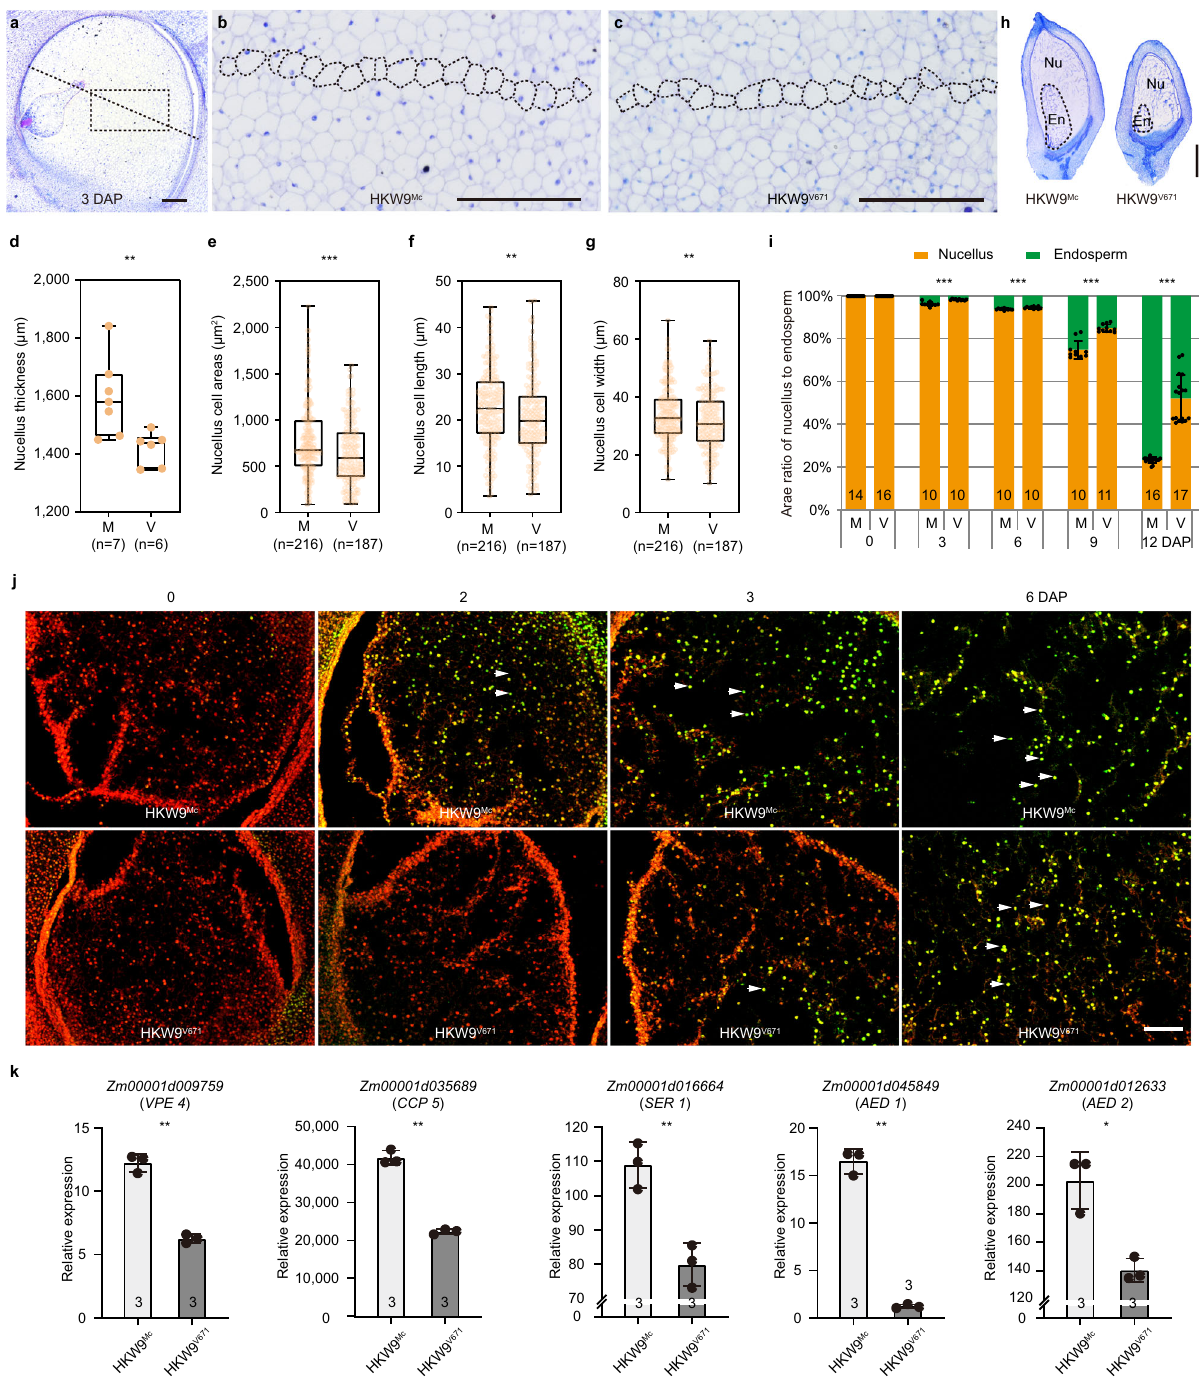
j TUNEL assays of the nucellus in the developing kernels from NILs. Nuclei were prestained with propidium iodide (PI) seen as red fl uorescence. The green and yellow fl uorescencecorrespond to the TUNEL-positivenuclei(partlymarked white arrows). k qRT-PCR analysis of PCD-related genes in the NILs kernels at 4 DAP. Zm00001d009759 for vacuolar processing enzymes 4 ( VPE4 ); Zm00001d035689 for cysteine protease 5 ( CCP5 ); Zm00001d016664 for serine proteases 1 ( SER1 ); Zm00001d045849 for aspartyl protease 1 ( AED1 ) and Zm00001d012633 for aspartylprotease2( AED2 ).Allexpressionlevelsfromthree biologicalrepeatswere normalized to Actin . Number on the bottom of each column is the sample size. Valuesaremeans±s.d.,two-tailedStudent ’ s t test.* P <0.05,** P <0.01,*** P <0.001. Scalebar=200 μ min( a – c );1mmin( h );500 µ min( j ).Sourcedataareprovidedasa Source Data fi